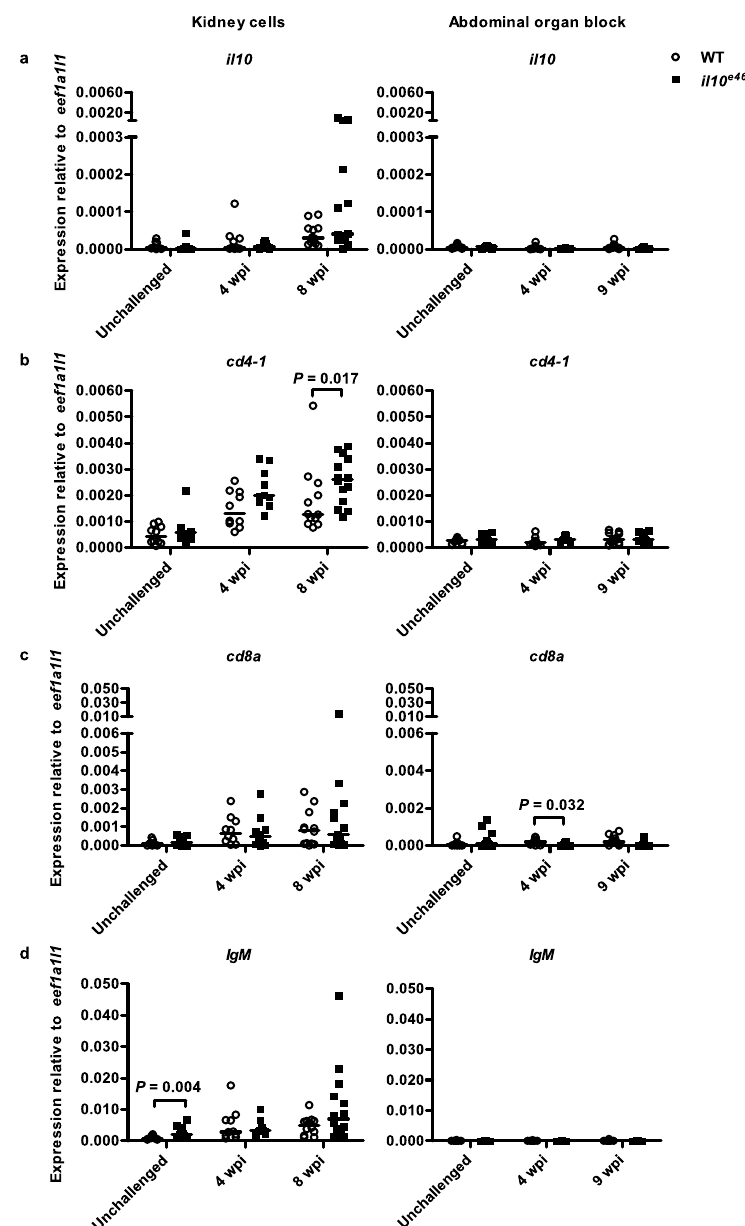
Figure 6. il10 e46/e46 mutant zebrafish have an elevated Th cell marker, cd4-1 , expression level at 8 weeks post a M. marinum infection. ( a – d ) The relative expressions of il10 and lymphocyte markers ( cd4-1, cd8a and IgM ) in kidneys of unchallenged il10 e46/e46 mutants ( n = 9–10) and WT control fish ( n = 9–10) and in the unsorted kidney cell populations of il10 e46/e46 mutants ( n = 10–14) and WT control fish ( n = 10–12) at 4 and 8 weeks post a low-dose (1–18 CFU) infection (on the left) as well as in the abdominal organ blocks (including kidney) of unchallenged il10 e46/e46 mutants ( n = 12) and WT control fish ( n = 11–12) and at 4 and 9 weeks post a low-dose (2–9 CFU) infection ( n = 9–12 and n = 11–12, respectively) (on the right) were measured with qPCR. Data are presented as a scatter dot plot and median. Note the different scales of the y axes and the divided y axis in panels a and c. Gene expressions were normalized to the expression of eef1a1l1 . Each dataset was collected from a single experiment. A two-tailed Mann-Whitney was used for the statistical comparison of